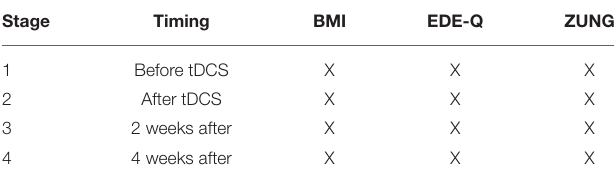
TABLE 2 | The timeline of the study.